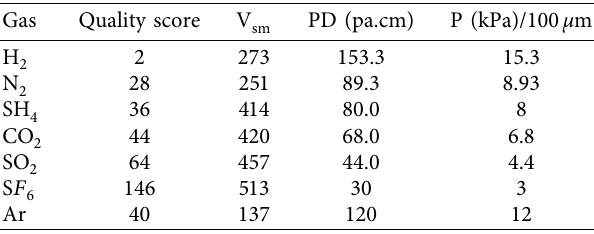
Table 4: SF6 breakdown discharge parameters.